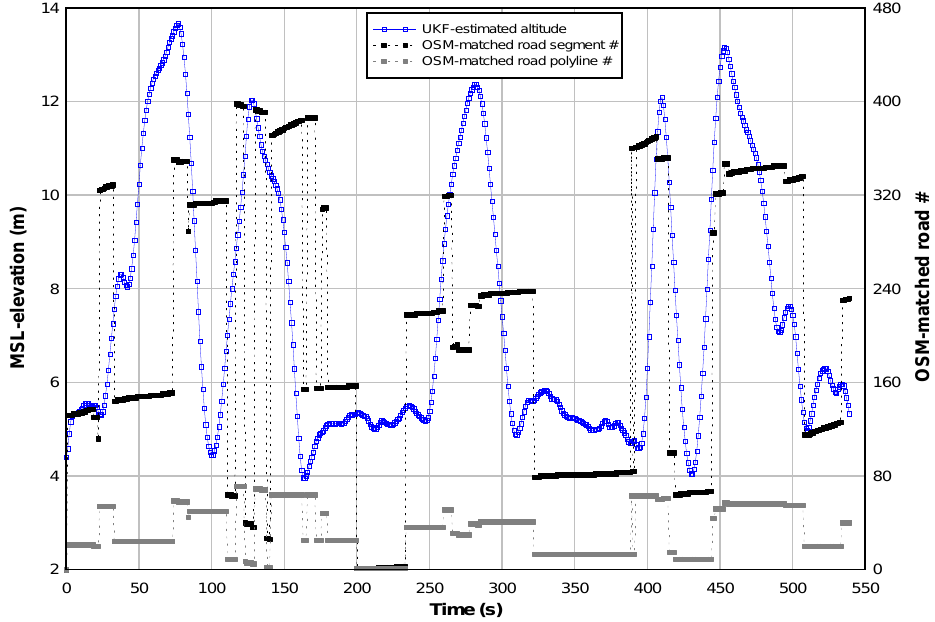
Figure 7. UKF-estimated altitudes vs. OSM matched roads.